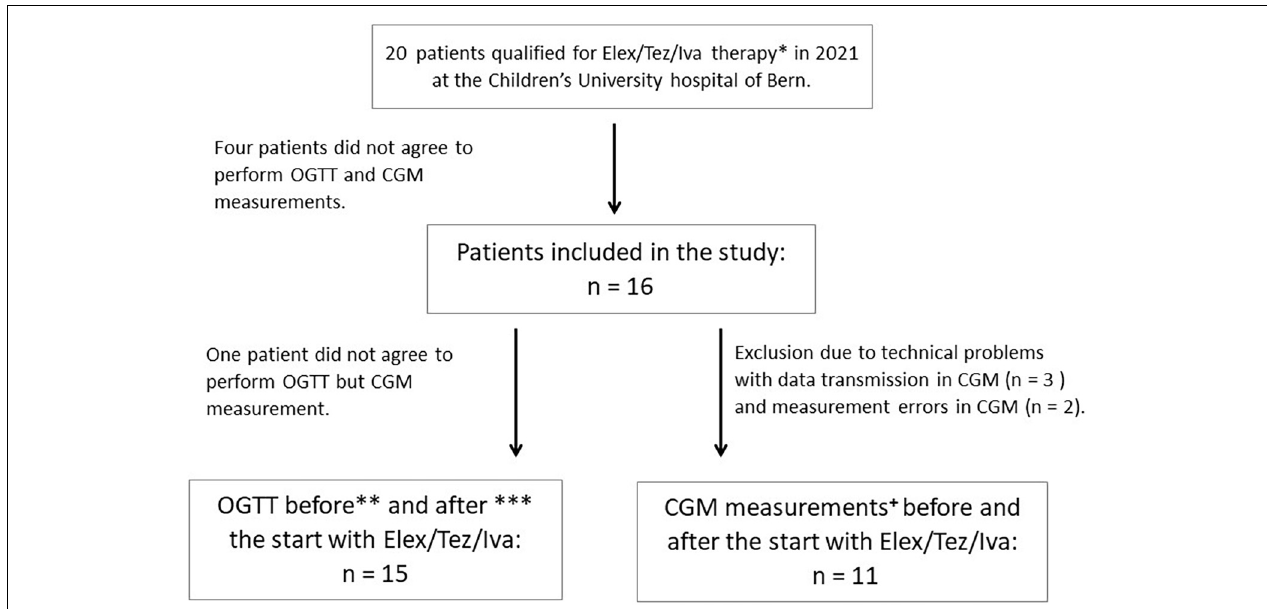
FIGURE 1 | Flowchart of study design. *Patients with known CFRD were excluded. **OGTT was performed 3 days to 6 weeks before the start with ELX/TEZ/IVA, except for three patients in whom OGTT was performed earlier (10 weeks, 4 months, and 6 months before the start) due to organizational reasons during routine clinical visits and disagreement of the patients to perform another OGTT. ***OGTT was performed 3–6 weeks after starting ELX/TEZ/IVA treatment, except for two patients in whom OGTT was performed after 8 and 10 weeks, respectively. All patients continued using ELX/TEZ/IVA until the second OGTT was performed. + CGM measures were performed 3 days before and 7 days after starting with ELX/TEZ/IVA. In one patient, CGM was only installed 2 days before the initiation of ELX/TEZ/IVA therapy due to organizational reasons in routine clinical